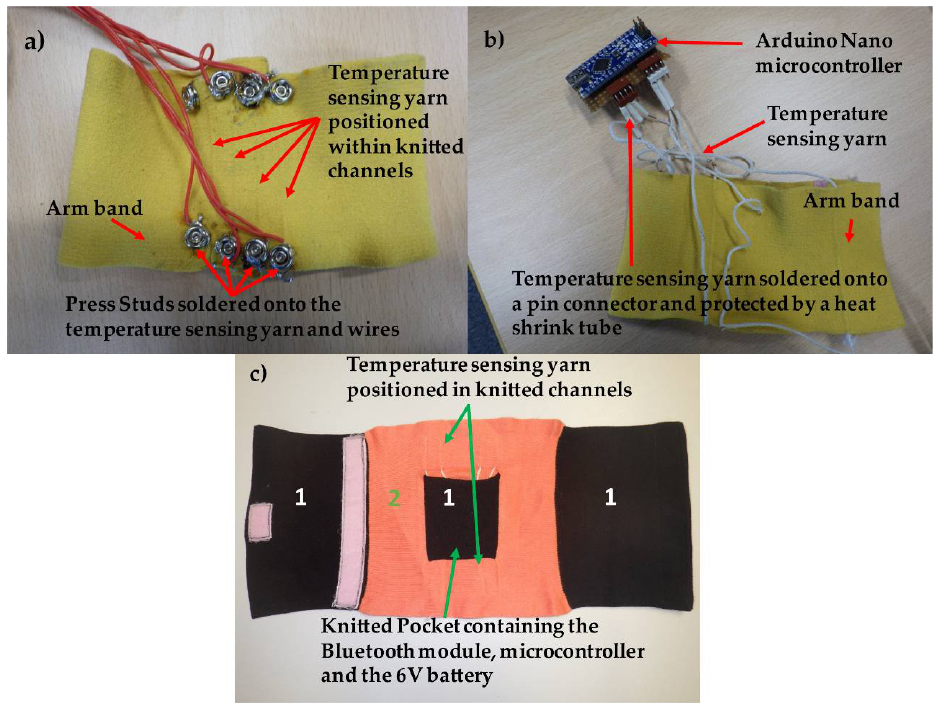
Figure 1. Annotated photographs of the three prototype armbands where ( a ) first armband prototype, ( b ) second armband prototype and ( c ) third armband prototype. The armbands were knitted with tubes to incorporate the temperature sensing yarns.